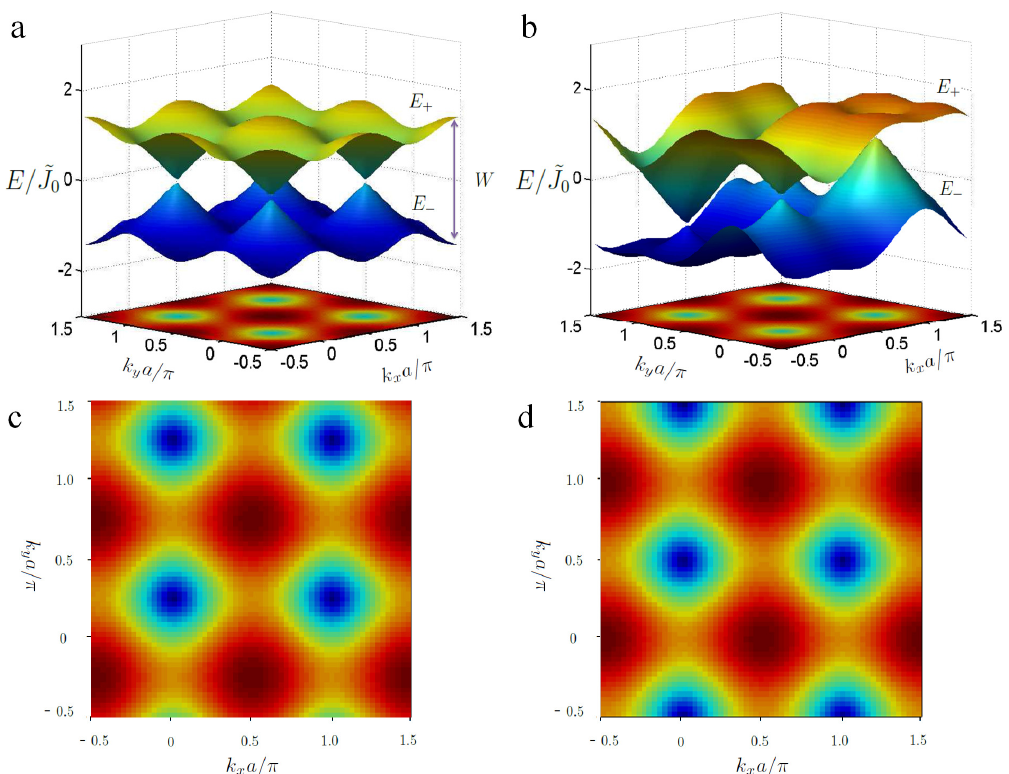
Figure 7. A three dimensional view of the energy spectrum plotted for a purely ( Φ = 0 non-abelian gauge field. The strength of SOC is ( a ) α = π /2 = β ; ( b ) α = π /2 + 0.25, β = π /2 − 0.25. The surface plot is an intensity map of the energy difference between E + and E − . The four green spots on the surface correspond to the four (Bosonic) Dirac points (at the zone centers) where the energy gap between the two bands vanishes. The red band and the blue band correspond to E + and E − , respectively. W is the maximum band-gap, that occurs at the zone boundaries; In ( c , d ) the location of the Dirac points on the momentum space are shown for 2 m π Φ = 0.75 and 1.5, respectively. With increasing Φ the Dirac points move along +ve k y axis. From [34]. (Reprinted figures with permission from Padhi, B.; Ghosh, S. Phys. Rev. A 2014, 90, 023627. Copyright (2014) by the American Physical Society. Source: